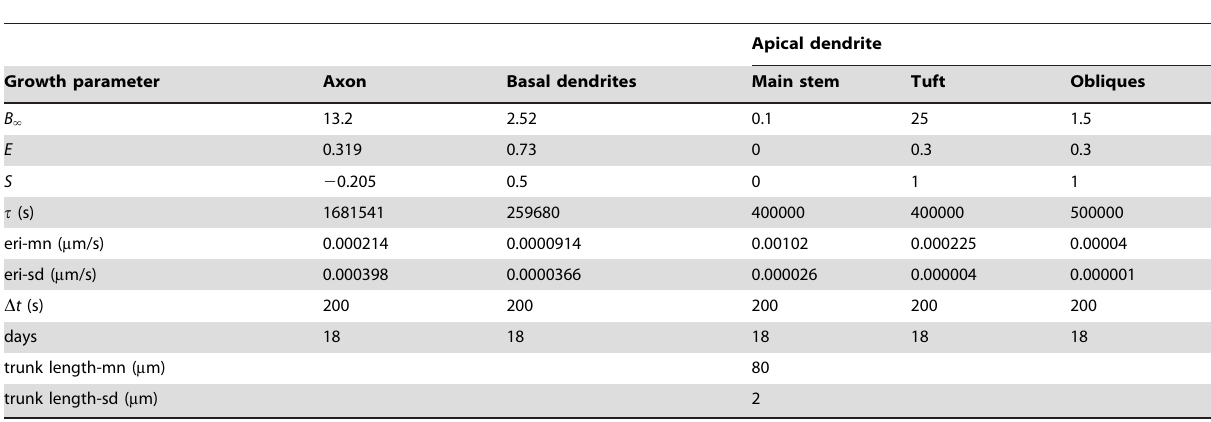
Table 1. Optimized values of the neurite outgrowth parameters in